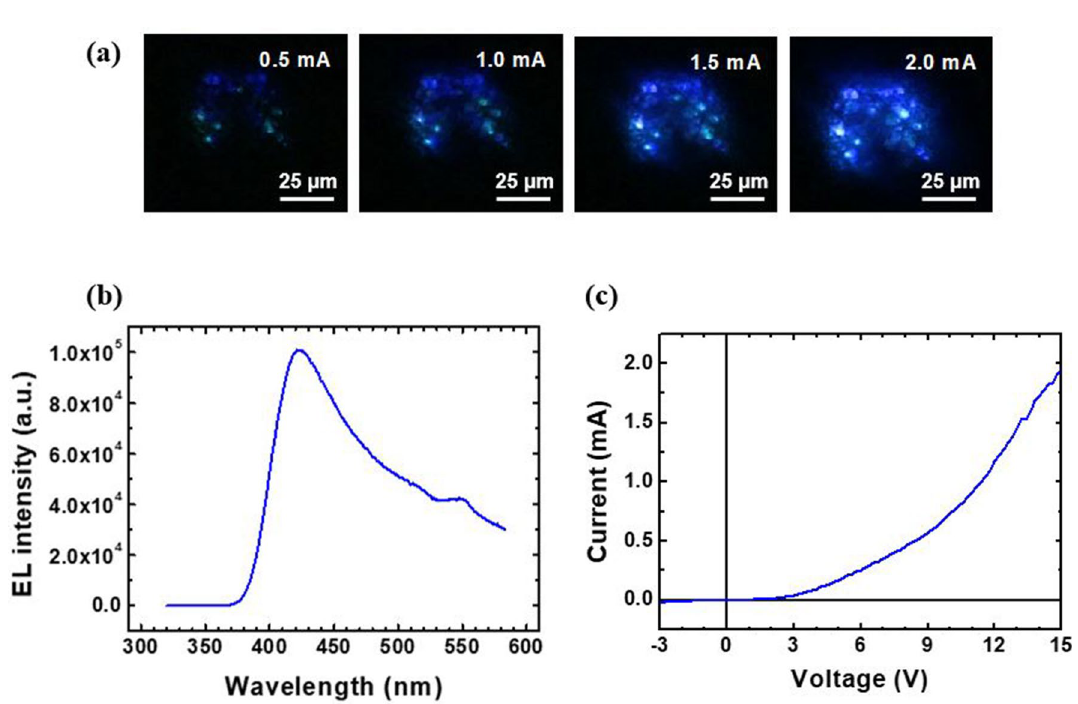
Figure 5. Visible micro-LEDs on graphene. ( a ) Optical microscopy images of light emission from the LED at different applied currents. ( b ) EL spectra from micro-LEDs ( c ) I–V characteristic curve of the